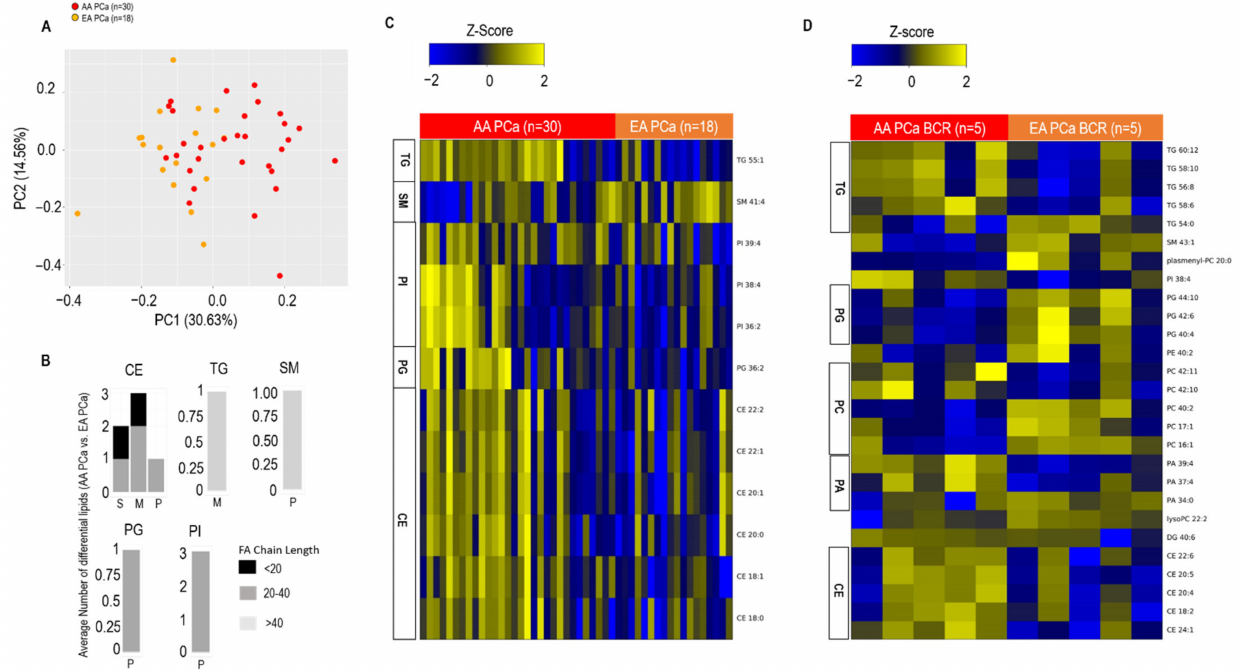
Figure 2. Altered lipidome in AA PCa vs. EA PCa tissue. ( A ) Principal component analysis using lipid profiles in 30 AA and 18 EA PCa tissues. ( B ) Number of altered lipids within each class stratified by fatty acid chain length (see legend) and degree of saturation. S: saturated, M: mono-unsaturated, P: poly-unsaturated ( ≥ 2 double bonds). ( C ) Heat map showing significantly altered lipids (stratified by fatty acid chain length: degree of saturation) in AA PCa vs. EA PCa patient prostate tissues. Shades of yellow and blue represent up and down regulated lipids, respectively (see color key). Lipid classes are marked on the left side of the heatmap. Lipid classes include TG: Triglycerides, SM: Sphingomyelin, PI: Phosphatidyl inositol, PG: Phosphatidyl Glycerol, CE: Cholesteryl Esters. ( D ) Heat map showing significantly altered lipids (stratified by fatty acid chain length: degree of saturation) comparing AA PCa and EA PCa with biochemical recurrence (BCR) within 5 years post-prostatectomy. Shades of yellow and blue represent up and down regulated lipids, respectively (see color key). Lipid classes are marked on the left side of the heatmap. For panels ( B) and ( C) , a permutation t -test coupled to Benjamin Hochberg false discovery rate (FDR < 0.1) correction was used to compute differential analysis. For panel ( D) , a Mann–Whitney test coupled to Benjamin Hochberg false discovery rate (FDR < 0.35) correction was used to compute differential analysis. For panel ( D) , altered lipids were selected at a minimum fold change of 2 with p -value < 0.05 (FDR < 0.35), comparing AA PCa BCR vs. EA PCa